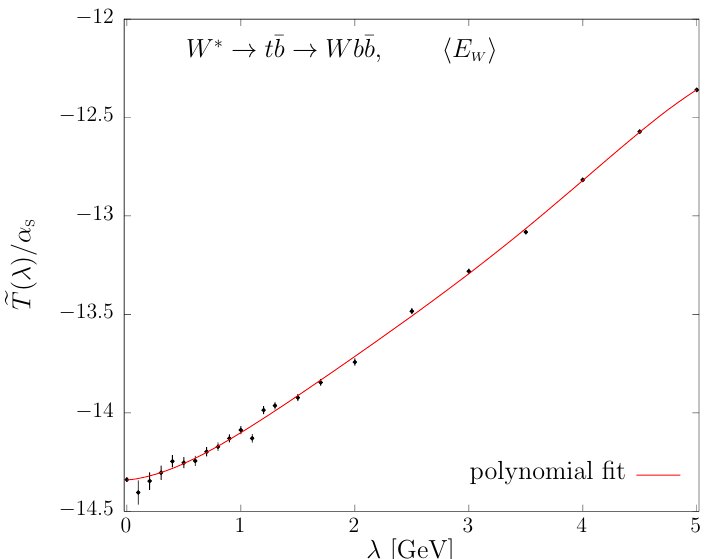
Figure 10 . Small (cid:21) behaviour of e T ( (cid:21) ) for h E